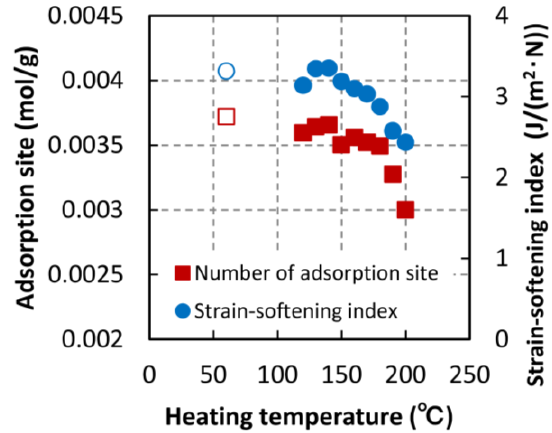
Figure 9. Number of adsorption site in heated